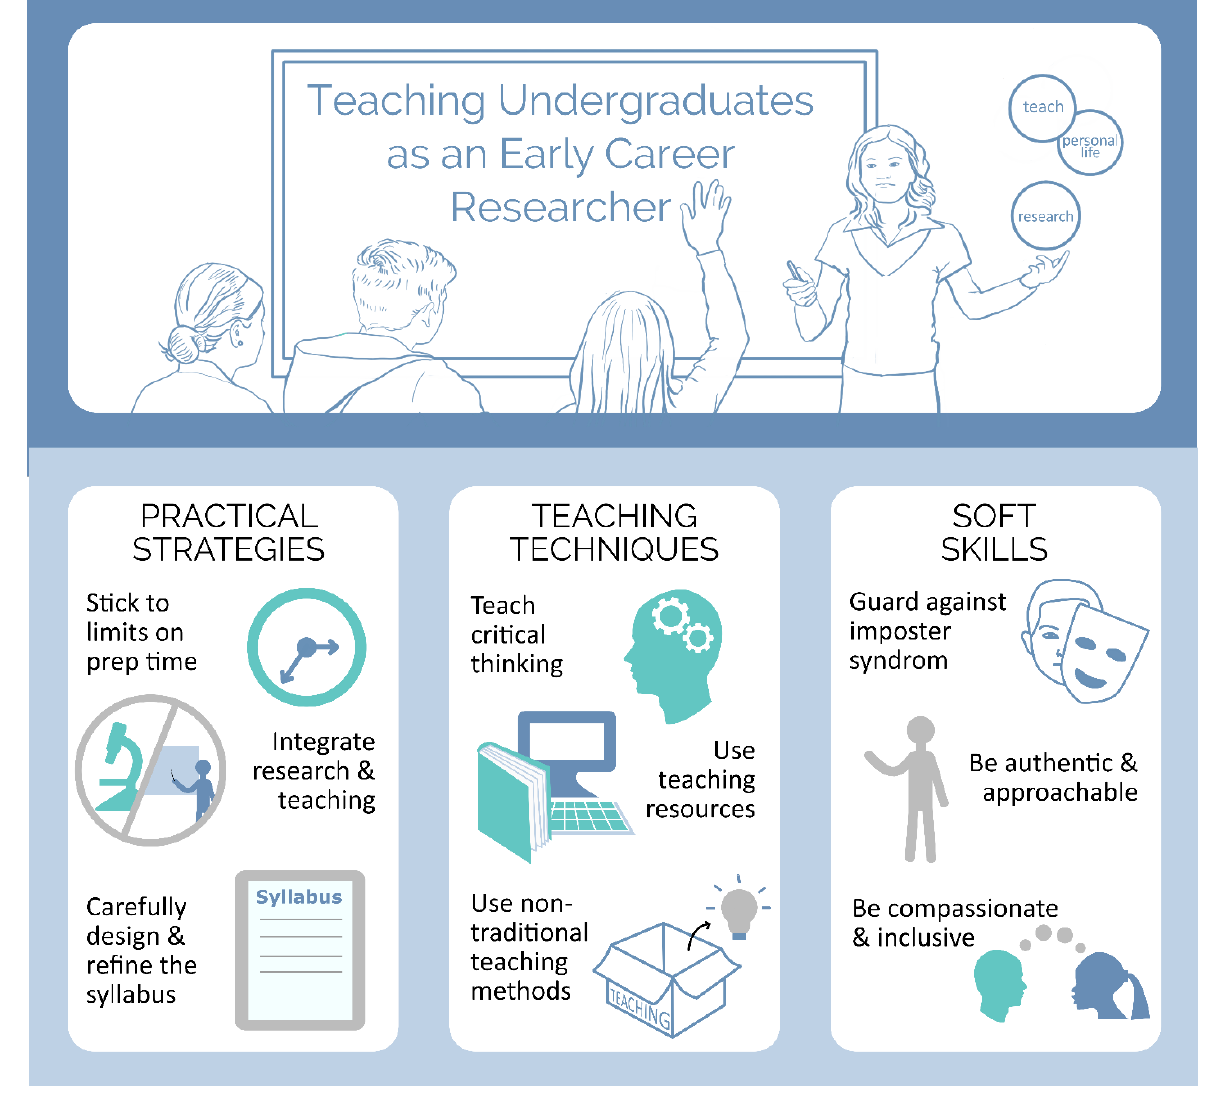
Figure 1. ECRs acting as course instructors for the first time face a difficult balancing act; following some of the strategies summarized here can help. Artistic credit: Sofia